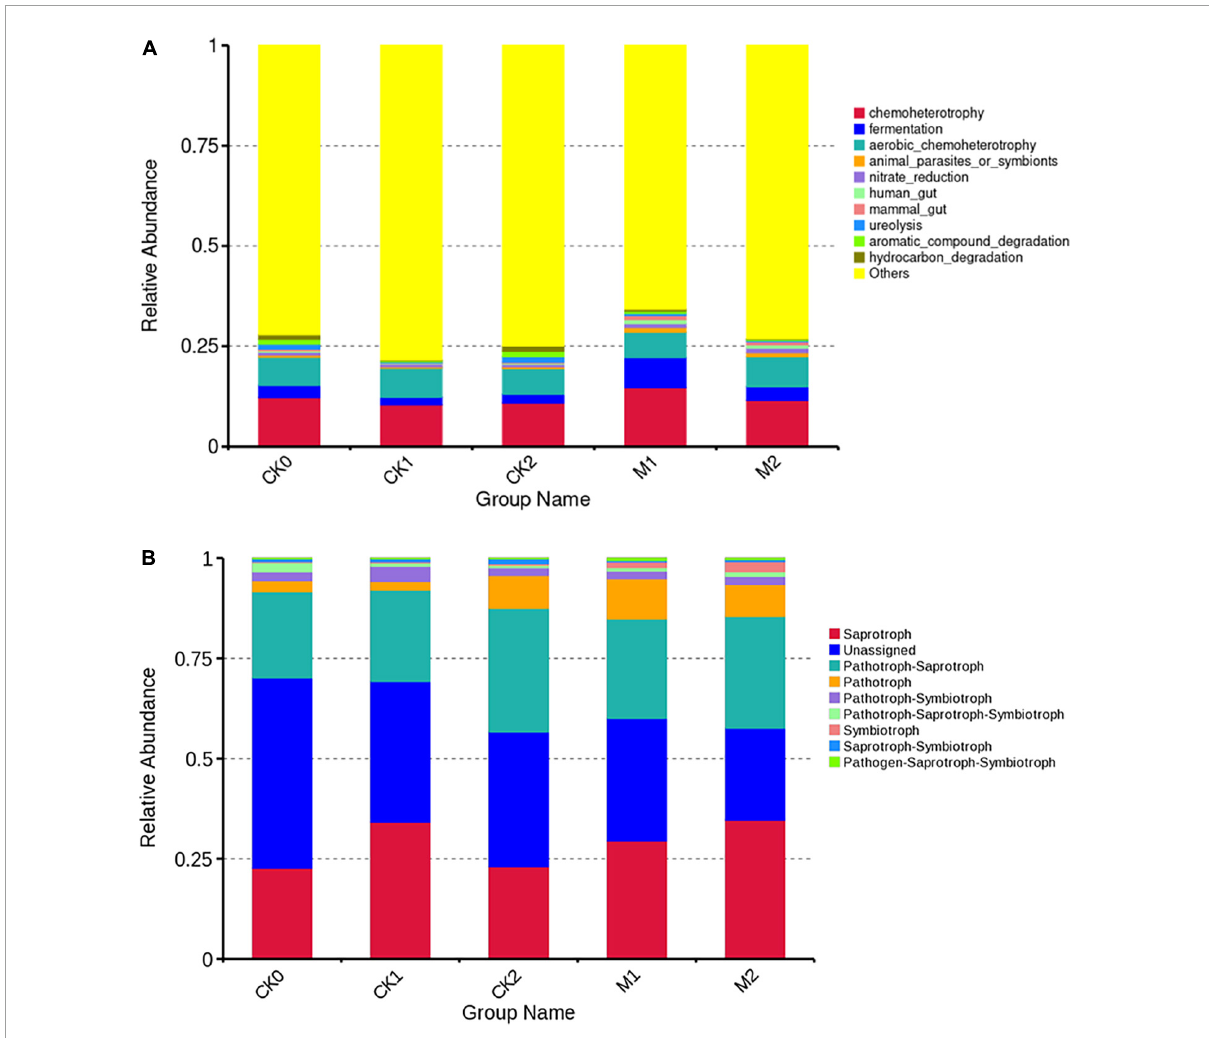
FIGURE6 Ecological function relative abundance of bacterial community (A) and fungal community (B)